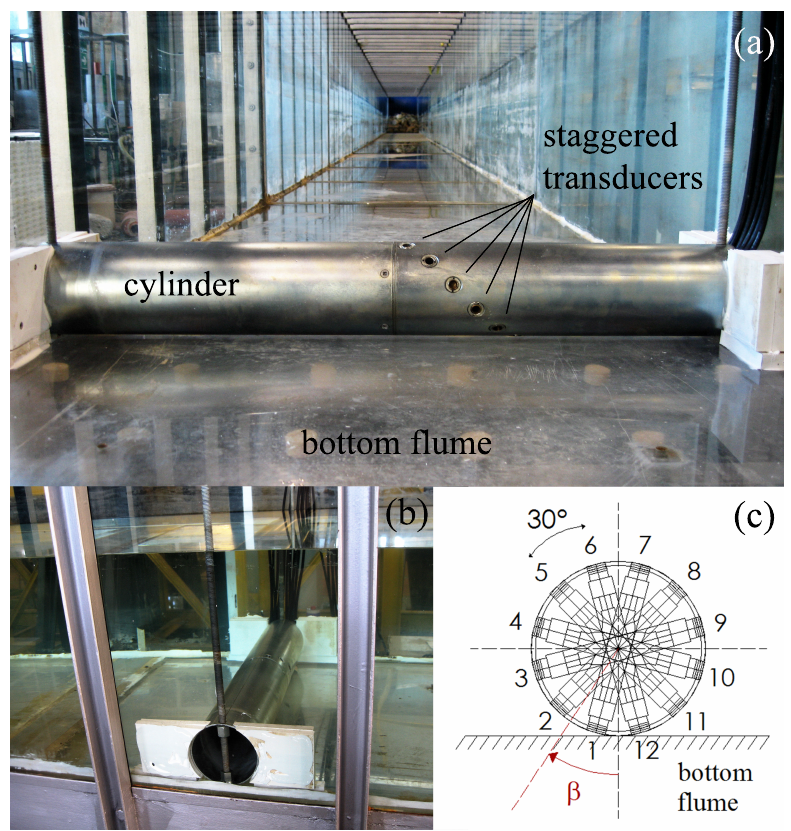
Figure 2. ( a ) Front view from the paddle of the cylinder and the staggered transducer arrangement in the wave channel; ( b ) View of the cylinder placement during the experiments; ( c ) Representative cross section of the transducers around the bottom-mounted